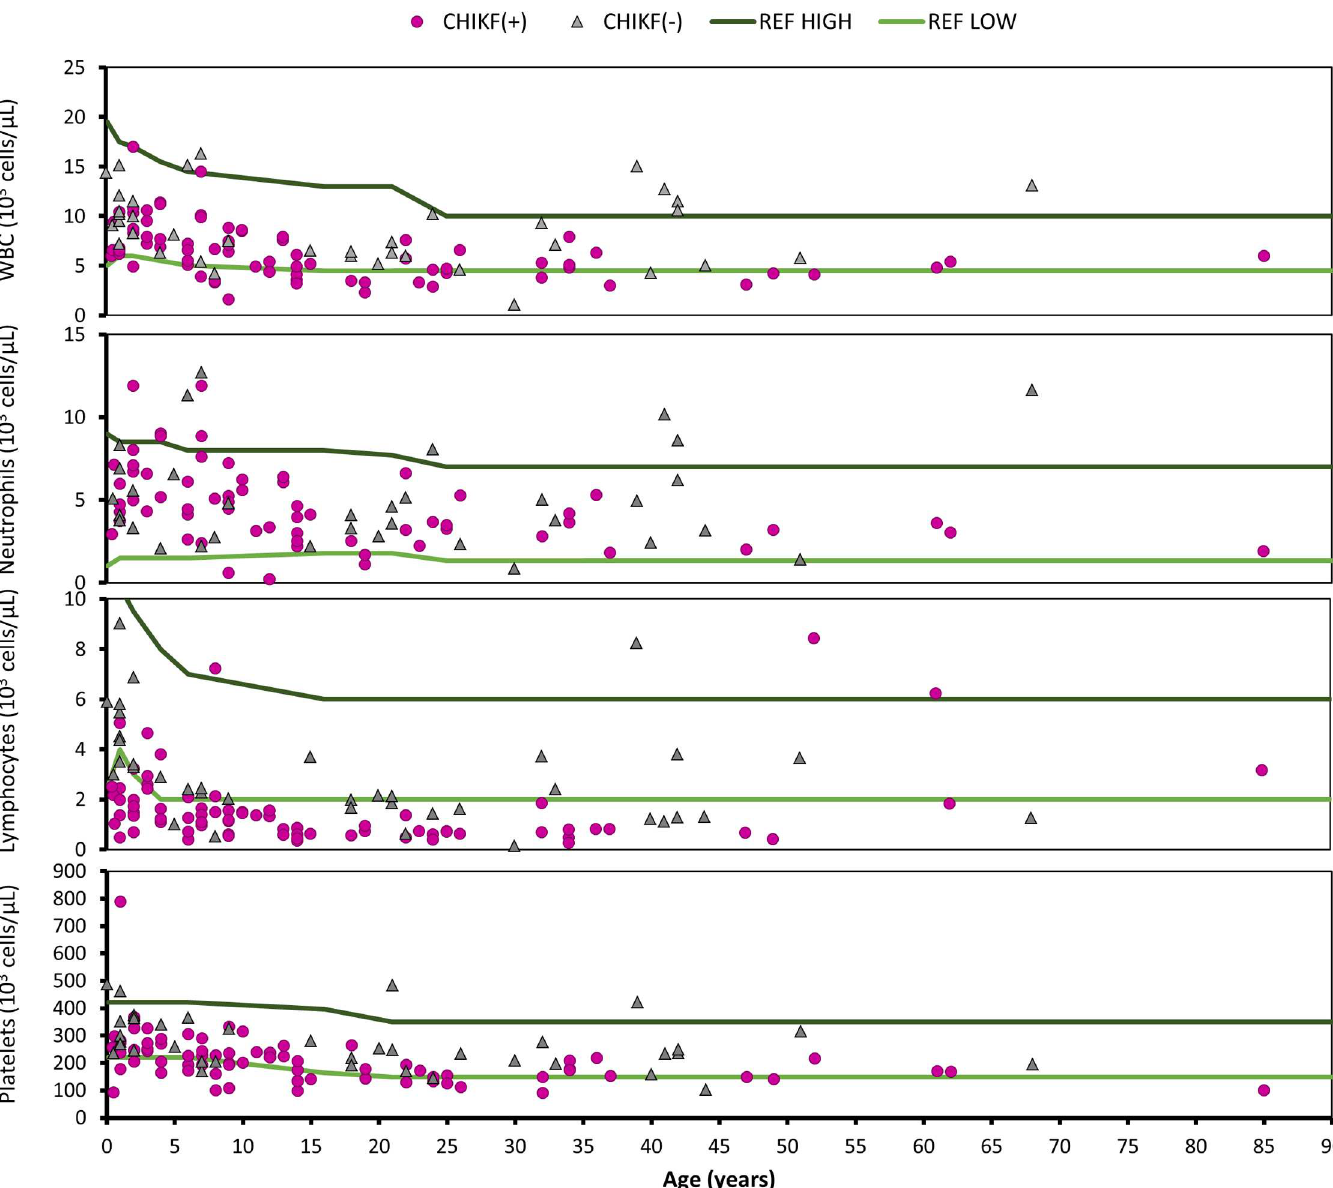
Fig 5. White blood cell values for CHIKF(+) and CHIKF(-) patients by age. Completeblood count (CBC) panel data for patients visiting an emergency clinic in La Romana, DominicanRepublic,which were matched to Chikungunya virus (CHIKV) diagnosticresults from discardedsamples. Patients positive for CHIKV RNA by RT-qPCR are represented by solid purplecircles, and patients negative for both CHIKV RNA and IgM antibodies[CHIKF(-)] are representedby grey triangles; green lines indicate suggestedlow and high reference